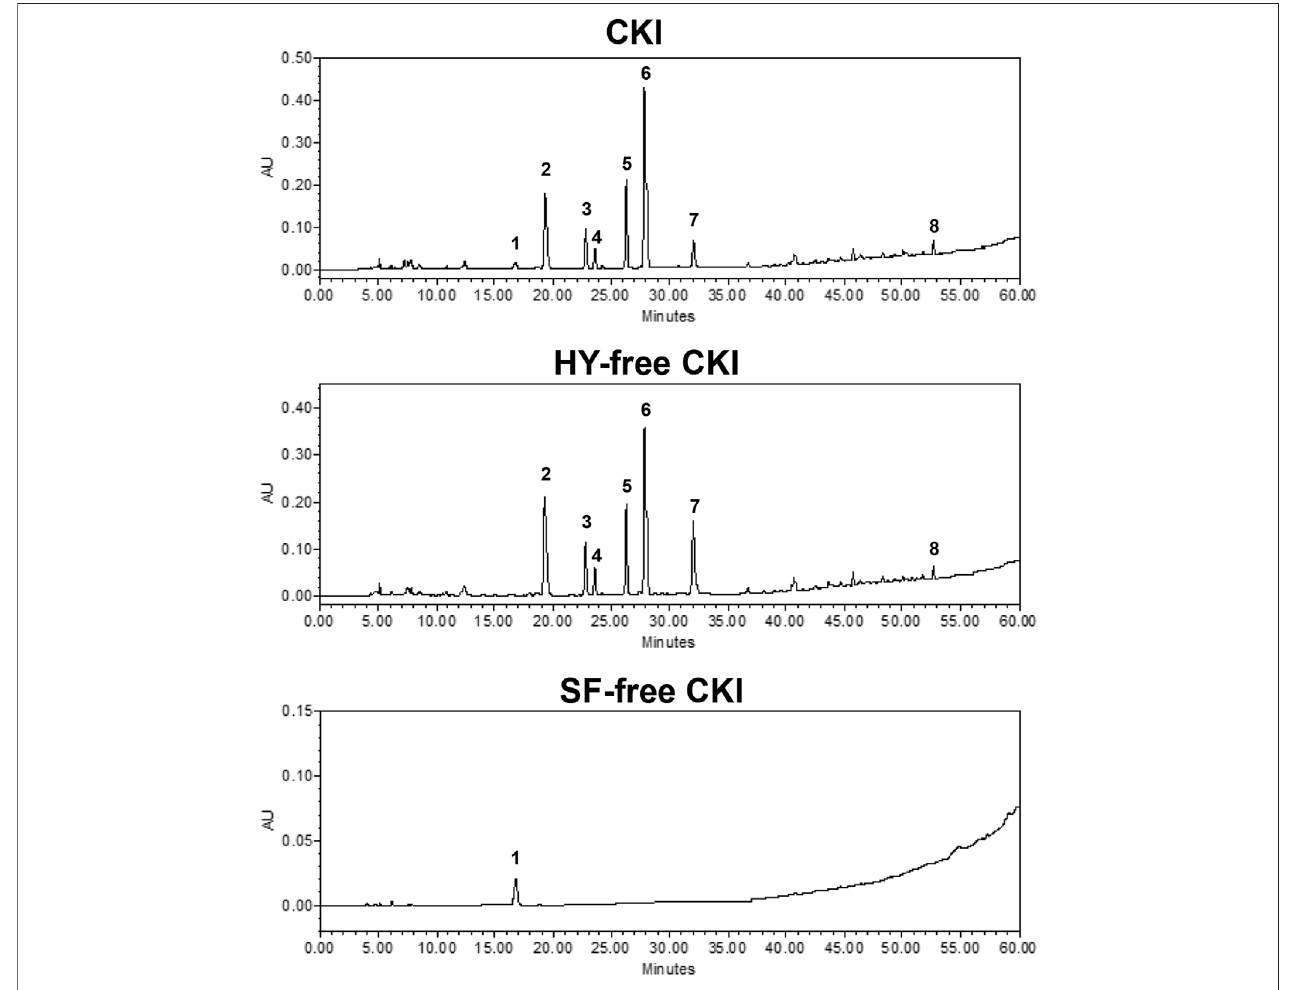
FIGURE 1 | Chromatogram fi ngerprints of CKI, HY-free CKI and SF-free CKI. 1. macrozamin (CAS # 6327-93-1); 2. matrine (CAS # 519-02-8); 3. sophocarpine (CAS # 145572-44-7); 4. sophoridine (CAS # 6882-68-4); 5. oxysophocarpine (CAS # 26904-64-3); 6. oxymatrine (CAS # 16837-52-8); 7. piscidic acid (CAS # 469-65-8); 8. trifolirhizin (CAS # 6807-83-6). CKI, Compound Kushen Injection; HY, Heterosmilax yunnanensis Gagnep.; SF, Sophora fl avescens Ait.